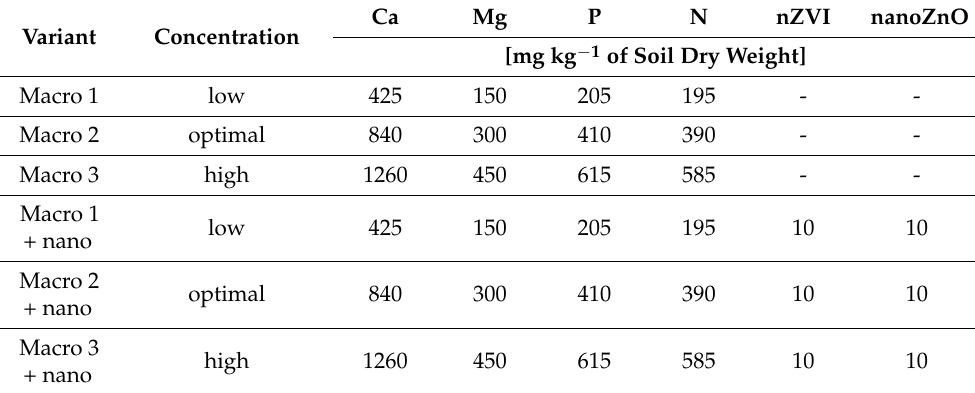
Table 2. Concentrations of macronutrients were selected for the tests.